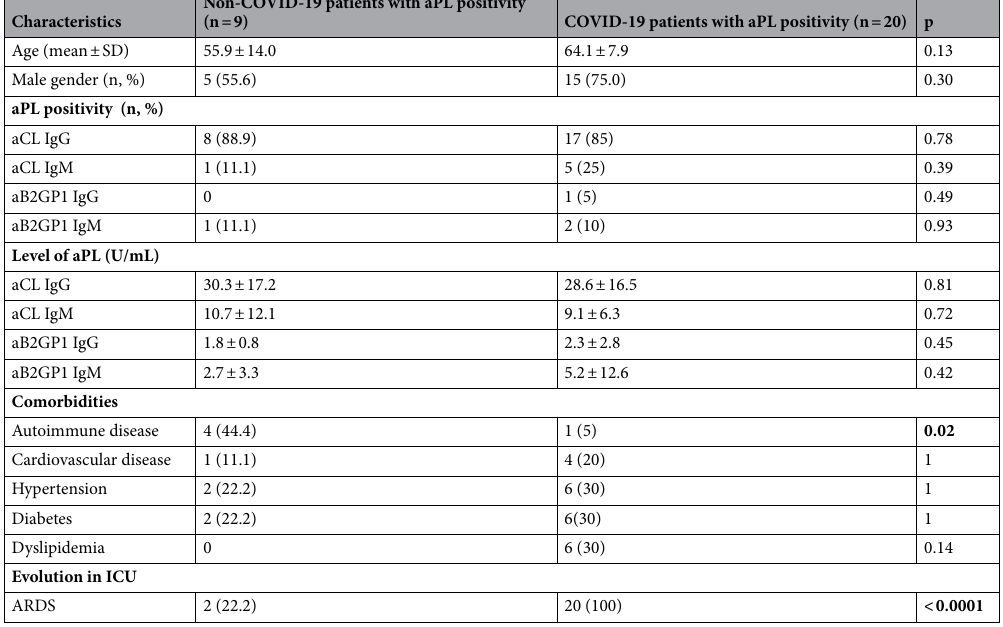
Table 3. Characteristics of patients admitted in ICU with aPL positivity. aPL antiphospholipid, aCL anti- cardiolipin, aB2GPI anti-beta-2 glycoprotein I autoantibodies, ICU intensive care unit, ARDS acute respiratory distress syndrome, n